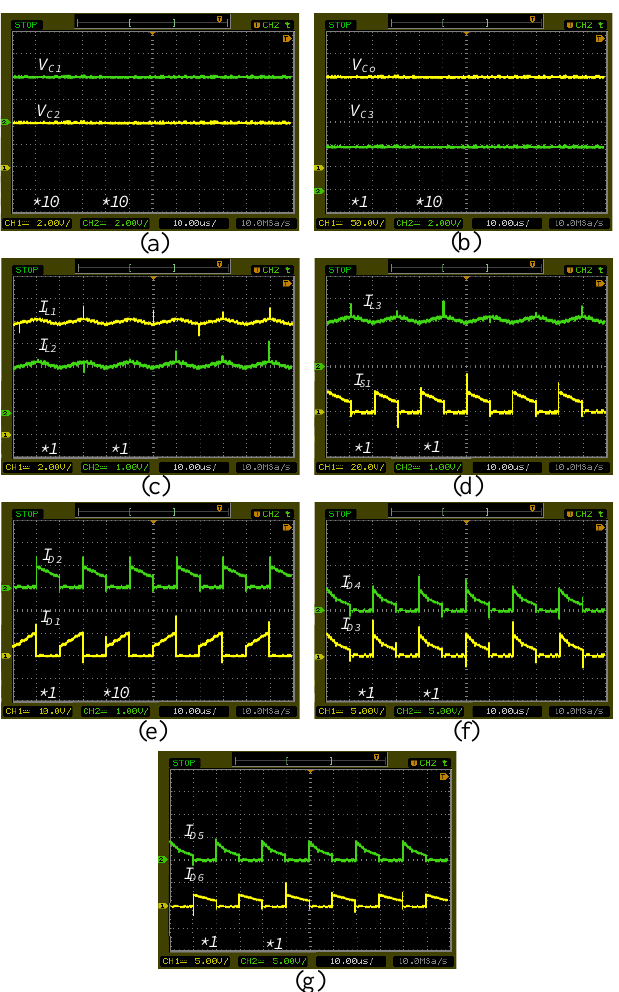
Figure 17. The experimental outcomes: ( a ) first and second capacitors’ voltage, ( b ) third and last ca- pacitors’ voltage, ( c ) first and second inductors’ current, ( d ) third inductor and switch current, ( e ) first and second diodes’ current, ( f ) third and fourth diodes’ current, ( g ) fifth and sixth diodes’